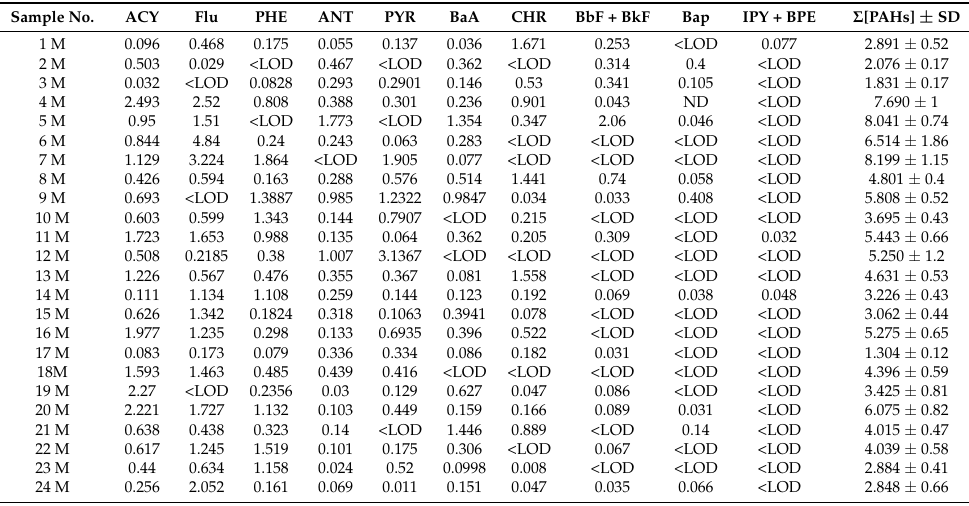
Table 3. Concentration of individual PAH in milk and dairy-based samples ( µ g/g). Sample